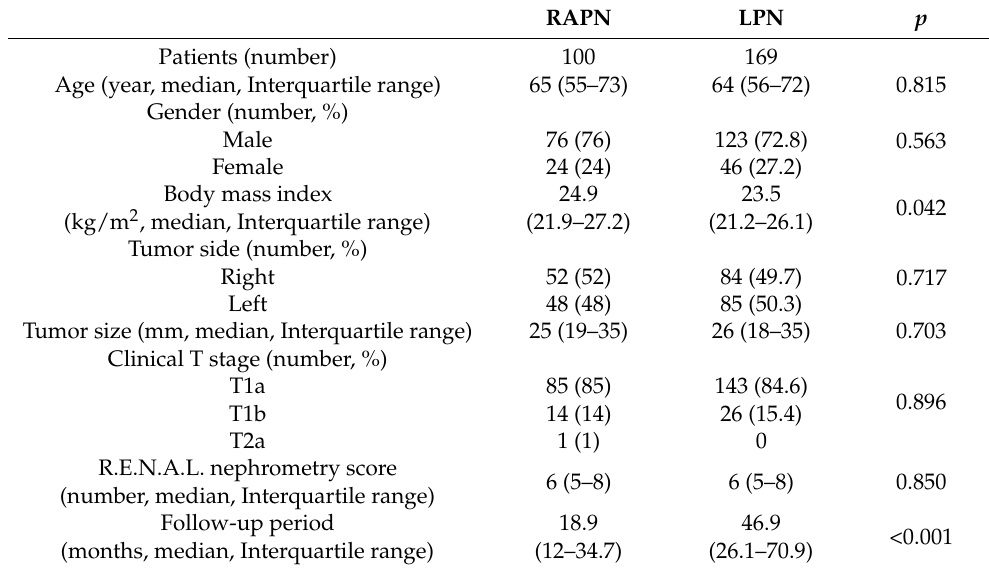
Table 1. Patient